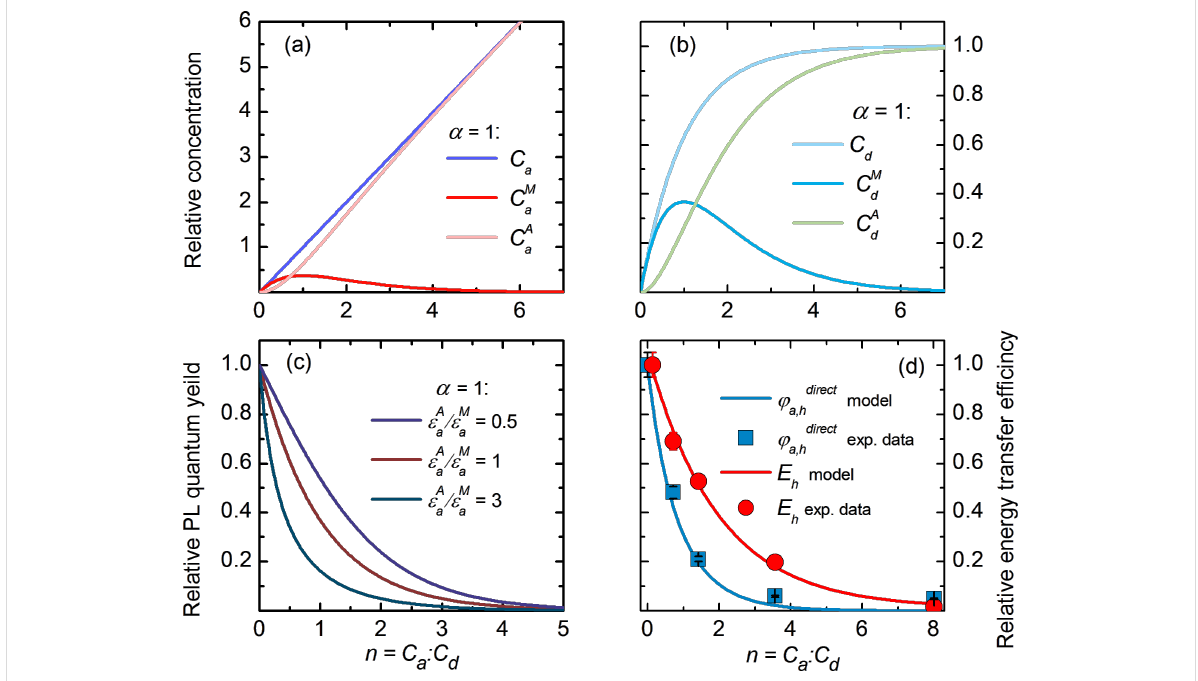
Figure 4: Typical results for a heterogeneous system of QD–molecule complexes, calculated from the model with α = 1. Relative concentrations of acceptor molecules (a) and QD donors (b) in complexes and QD–monomer/QD–aggregate complexes as a function of the relative acceptor concen- tration n . (c) Dependencies of relative acceptor PL QY ( ) on relative acceptor concentration n for different ratios of monomer and aggregate extinction coefficients. (d) Experimental data of the normalized energy transfer efficiency (red spheres) and normalized acceptor PL QY (blue squares) in a heterogeneous system of QD–molecule complexes as a function of n calculated with Equation 7 and Equation 8, respectively. Continu- ous lines are the fitting of experimental data with E h (red line) and (blue line) curves calculated from the model described above with Equation 12 and Equation 11 ( α = 1 and extinction ratio =